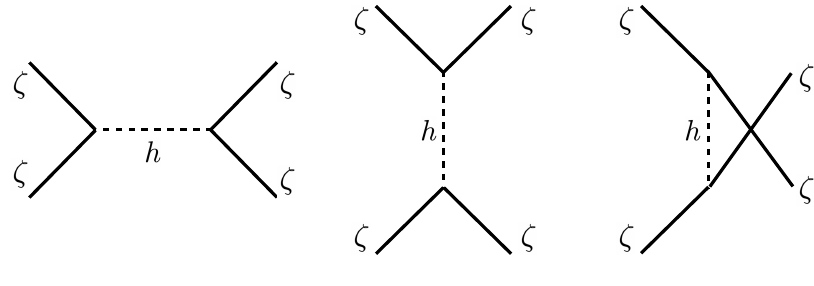
Figure 3 . Tree-level diagrams with ζ -legs and h -propagators: case (b)